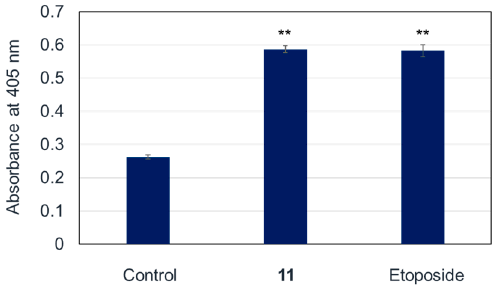
Figure 5. Caspase-3 activity in the lysates of cells treated with 11 or etoposide. HL-60 cells were incubated at 37 °C for 24 h with 10 µM of 11 or 15 µM of etoposide. The data are presented as the mean ± S.E.M. of three experiments. ** p < 0.01 vs. the control group readings.